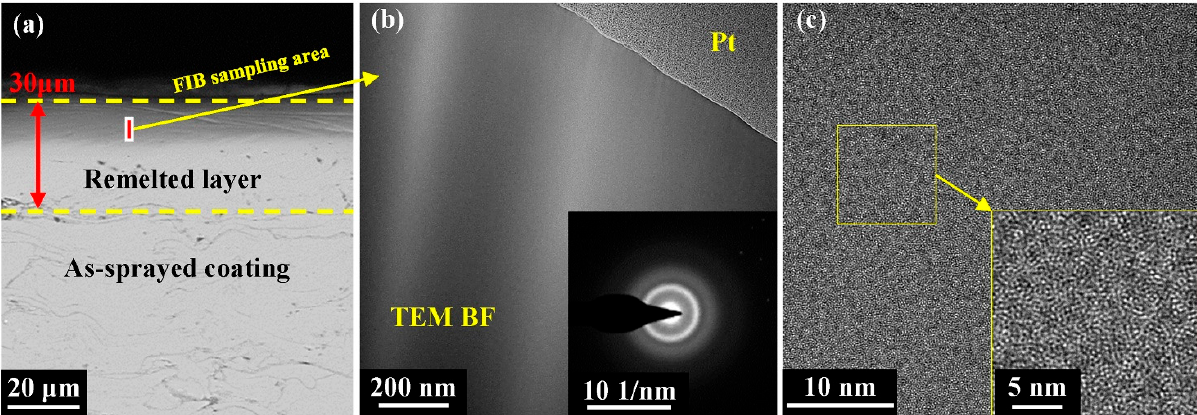
Figure 7. ( a ) SEM image and FIB cutting position of the remelted layer; ( b ) TEM BF images and selected-area diffraction patterns (inset) of the remelted layer; and ( c ) HRTEM images.